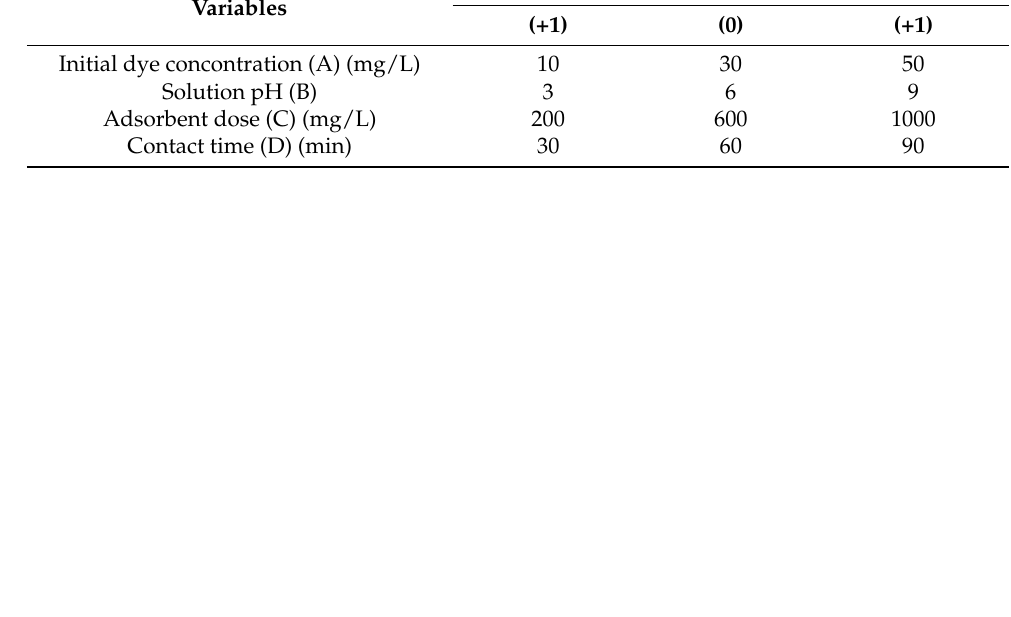
Table 1. High, center and low levels of the independent variables investigated in the present study.